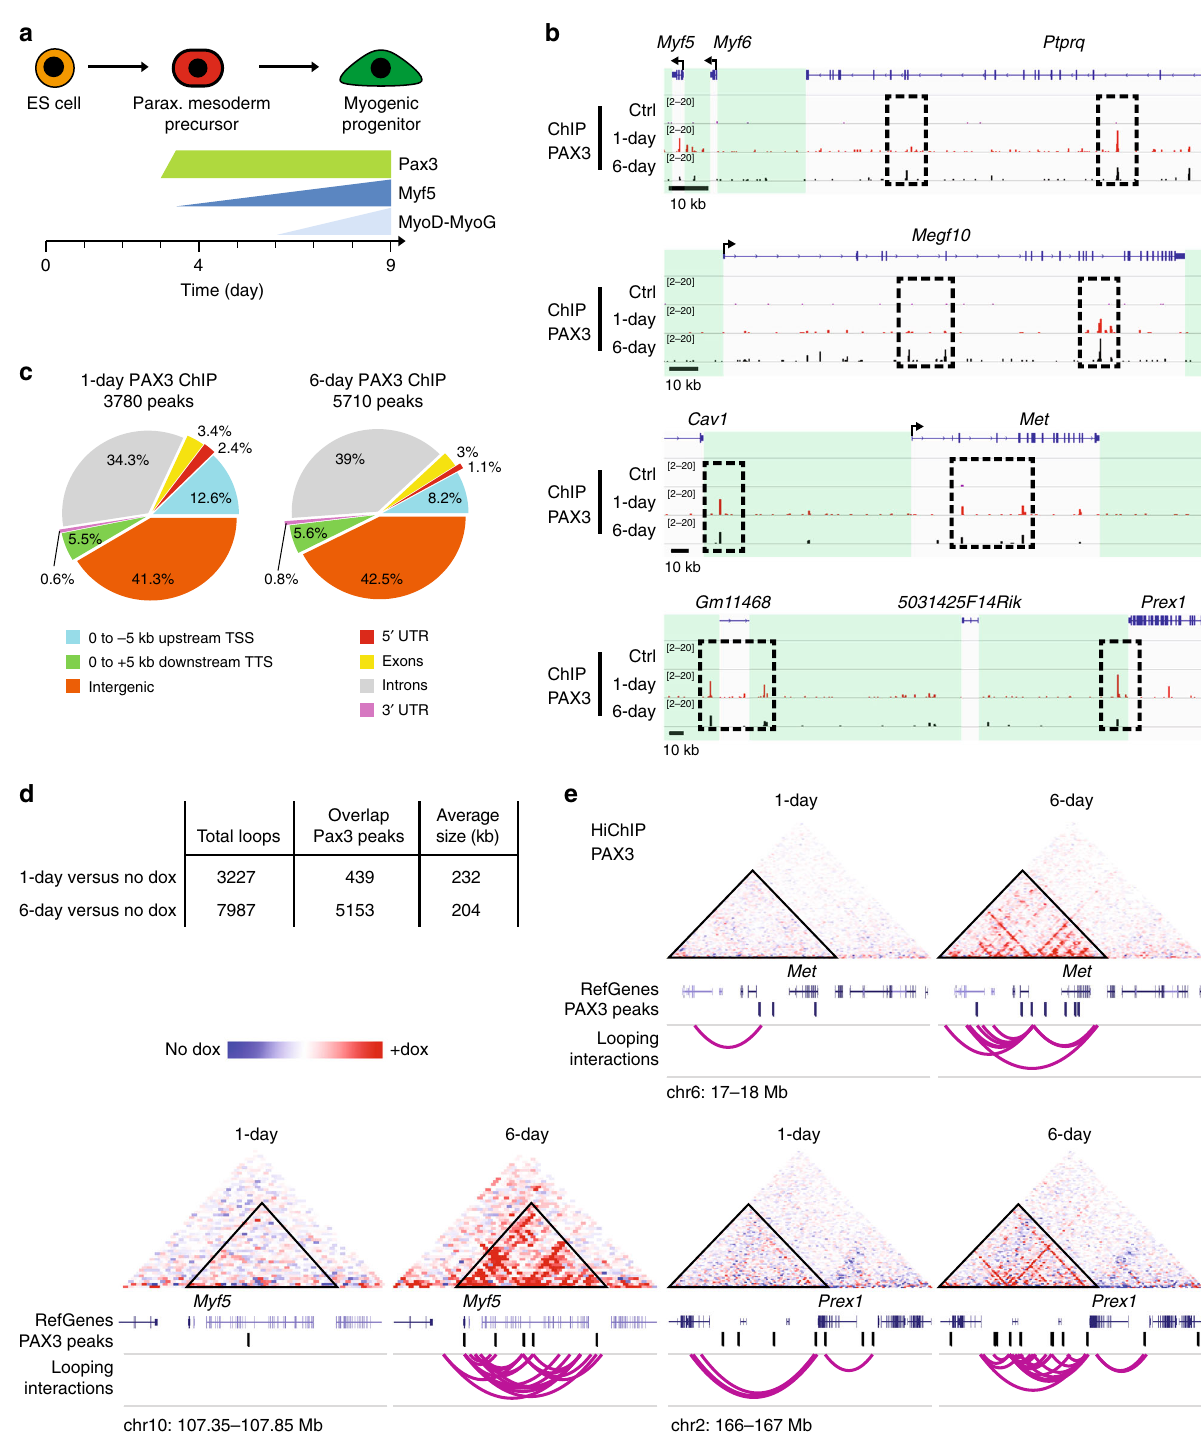
Fig. 1 Pax3-bound elements establish long-range interactions. a Schematic representation of Pax3-induced myogenesis during mouse ES cell differentiation. Pax3 is induced at day 3 of differentiation using a doxycycline-dependent system. Twenty-four hours post Pax3-induction (1-day), only Myf5 transcript is detectable. Myod and Myog are expressed in the later stages of myogenic commitment (transcripts are detectable following 3/4-day Pax3 induction). b IGV track displaying PAX3 binding at Myf5, Megf10, Met , and Prex1 loci in 1-day and 6-day Pax3-induced cells. Dashed black squares indicate PAX3-bound loci. Green boxes represent intergenic regions. Black arrow represents the transcription start site. c Functional annotation of PAX3 peaks from 1-day and 6- day Pax3-induced cells. d Number of long-range interactions (loops) detected by PAX3 HiChIP. e Long-range interactions at the Met , Myf5 , and Prex1 loci in 1-day and 6-day Pax3-induced cultures. The contact maps were normalized for sequencing depth and visualized as ratio relative to the background (non- induced PAX3 HiChIP). Triangles indicate domains of long-range chromatin interactions involving PAX3-bound sites (position of PAX3 peaks, genes, and chromosome coordinates are showed below). Scale: maxrange = 0.2. Arcs indicate looping interactions identi fi ed by